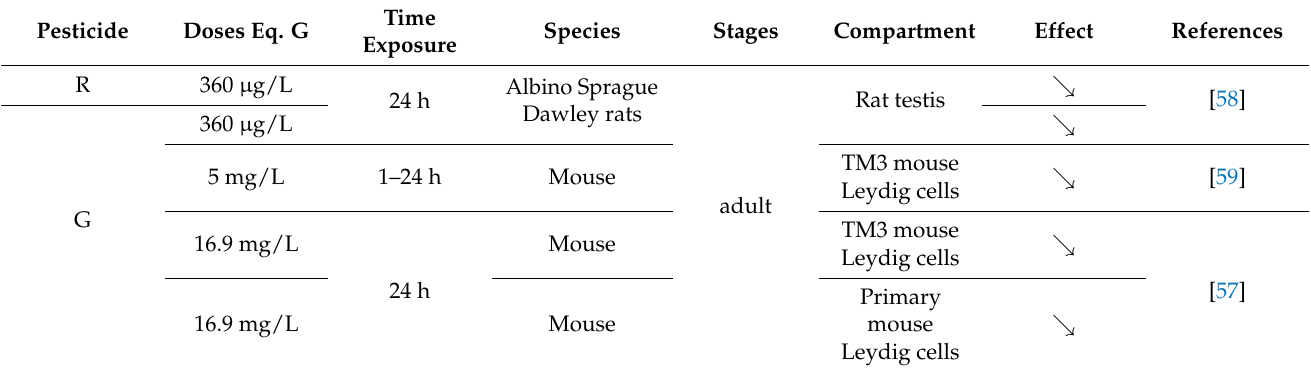
Table 5. Summary of in vitro studies of G or GBH exposure impact on testosterone secretion. Eq: equivalent. Numbering in brackets indicates